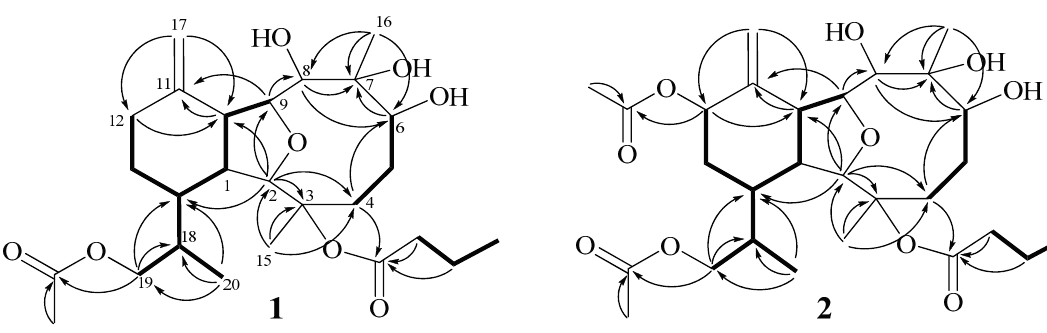
Figure 1. Selected COSY ( ▬ ) and HMBC ( → ) correlations of 1 and 2